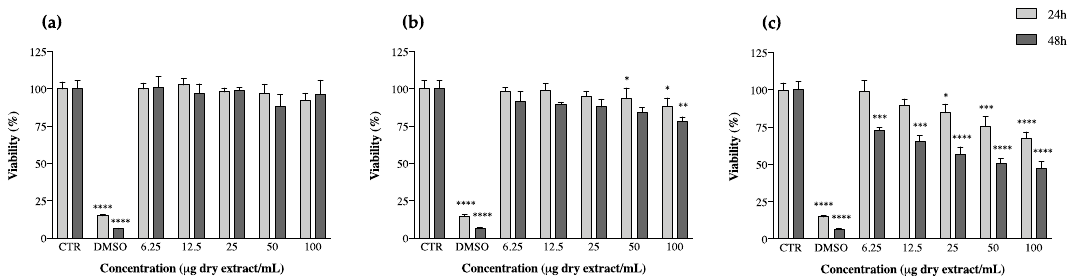
Figure 3. Keratinocyte (HaCaT) viability after 24 and 48 h of incubation with cyanobacteria acetone extracts. ( a ) Alkalinema aff. pantanalense LEGE15481, ( b ) Nodosilinea (Leptolyngbya) antarctica LEGE13457 and ( c ) Leptolyngbya -like sp. LEGE13412. Results are expressed as % of MTT reduction vs. the untreated control (CTR). DMSO (20%) represents the positive control. Results are expressed as the mean ± SD of at least four independent assays, performed in duplicate. * p < 0.05, ** p < 0.01, *** p < 0.001, **** p < 0.0001 (ANOVA, Tukey HSD) .